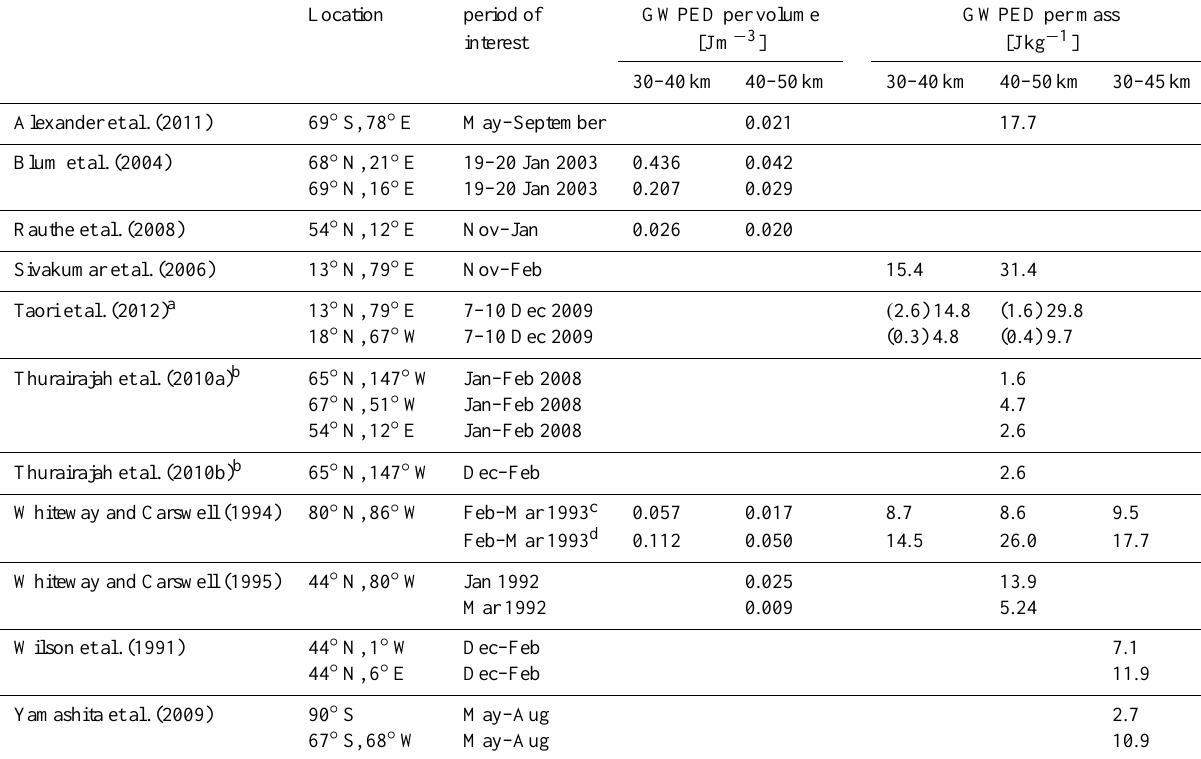
Table 1. Mean GWPED for different altitude regions during